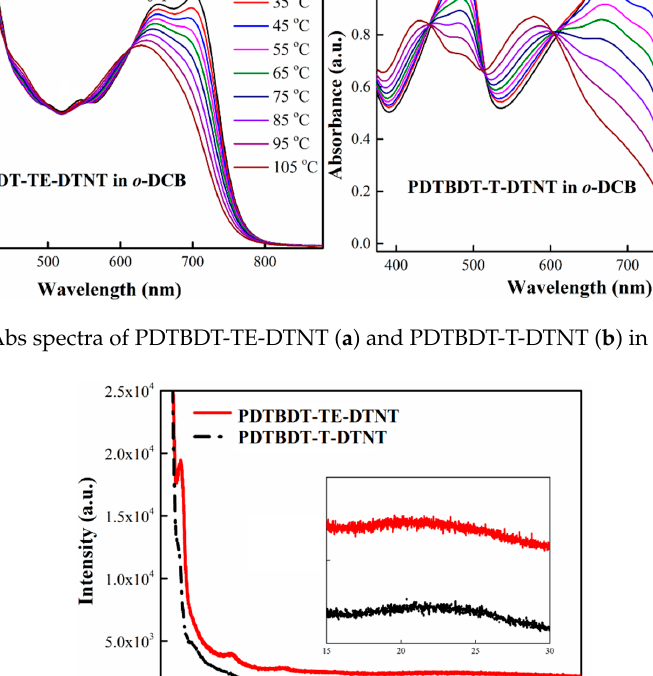
Figure 2. TD-Abs spectra of PDTBDT-TE-DTNT ( a ) and PDTBDT-T-DTNT ( b ) in o- DCB solution.